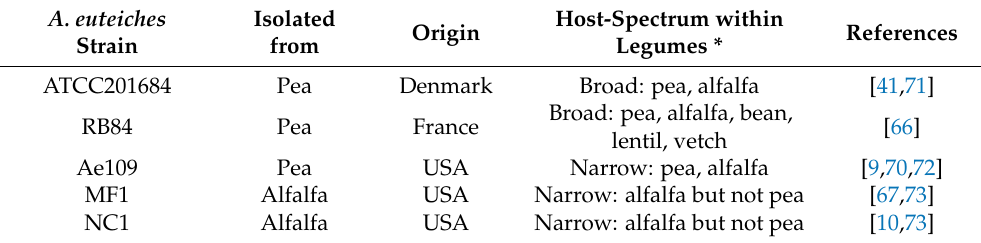
Table 2. Origin and host spectrum of A. euteiches strains.